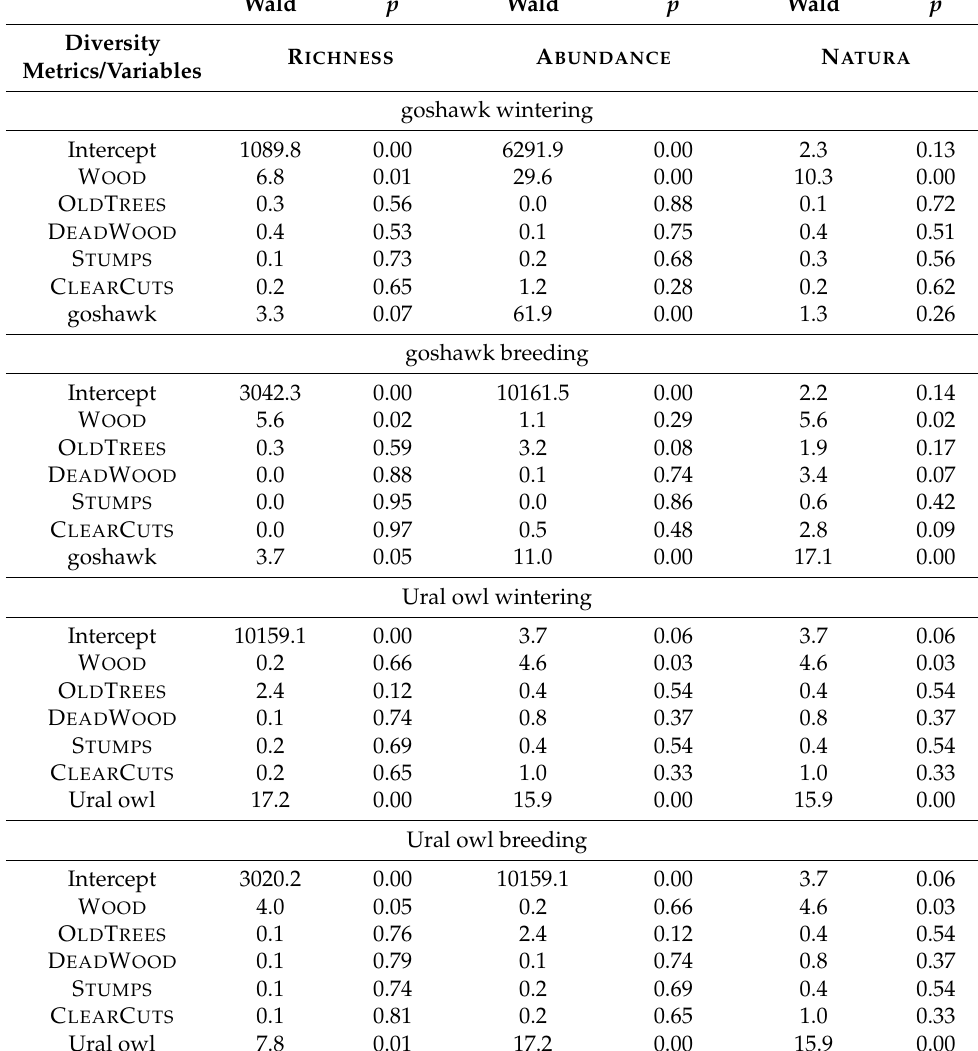
Table 3. Statistical significance of univariate models constructed for selected environmental variables and raptor occurrence (goshawks or Ural owls) as explanatory variables for three bird diversity metrics (species R ICHNESS , A BUNDANCE , and species annexed in Bird Directive of UE—N ATURA ). Wald p Wald p Wald